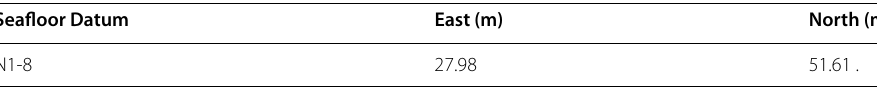
Table 1 Seafloor datum measurement